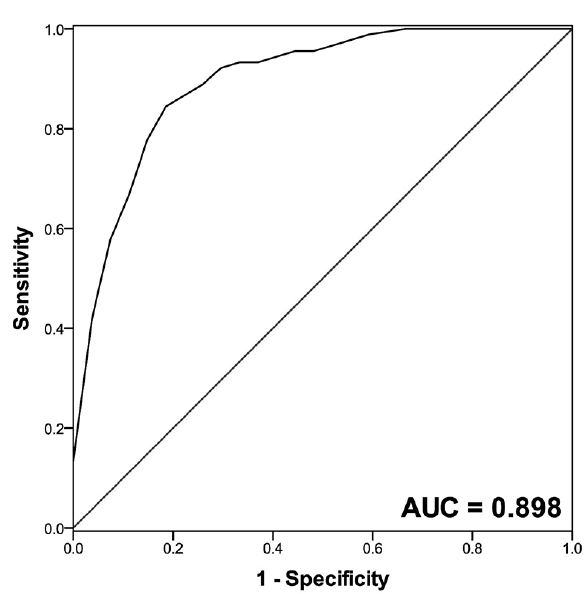
Figure 2 – ROC curve based on the expression level of miR-146. miR- 146 could discriminate epidural fibrosis patients from controls with the AUC value of 0.898. The sensitivity and specificity were 0.867 and 0.815,